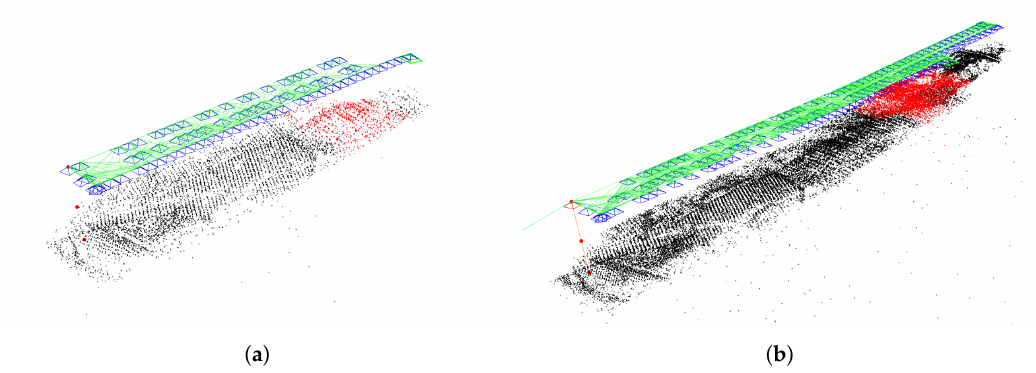
Figure 3. Differences between the original Figure 3a and the augmented version Figure 3b. ( a ) Original ORB-SLAM2. ( b ) Augmented GPS-SLAM.